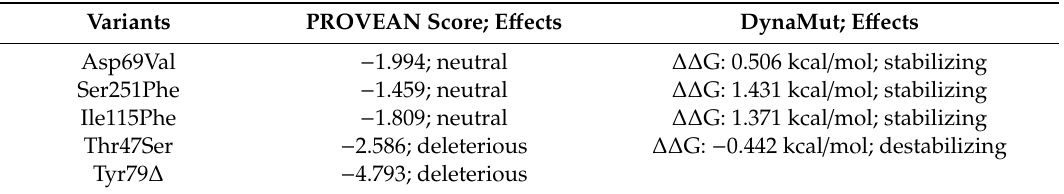
Table 1. Comparative studies by PROVEAN and DynaMut for protein stability prediction.